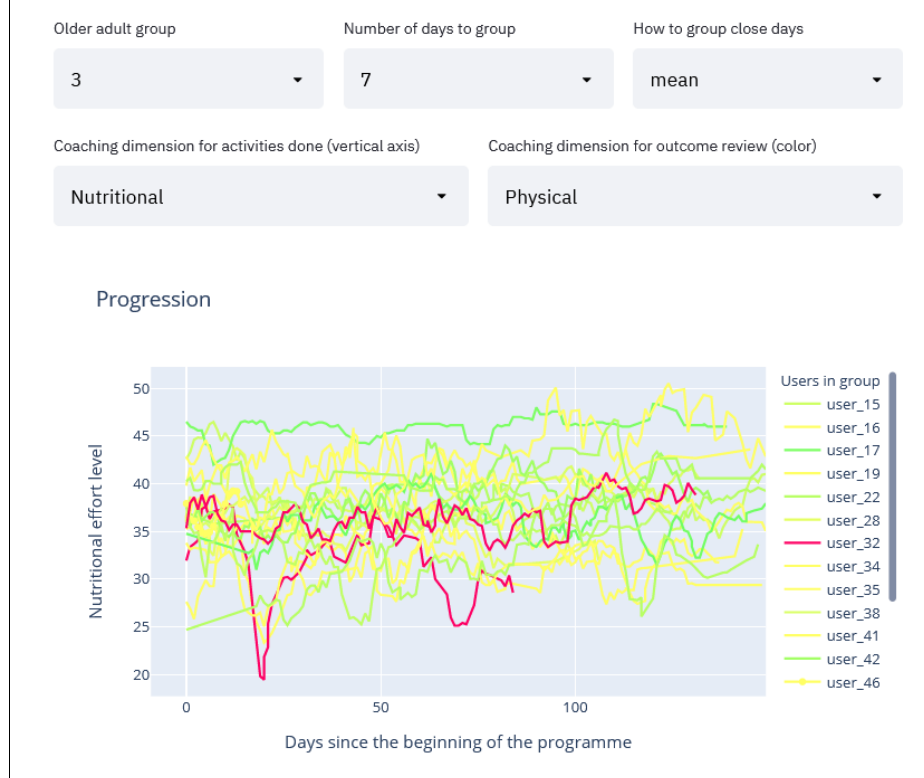
Figure 10. Evolution graph of Group 3. Showing the nutritional activity level and coloring by physical improvement.